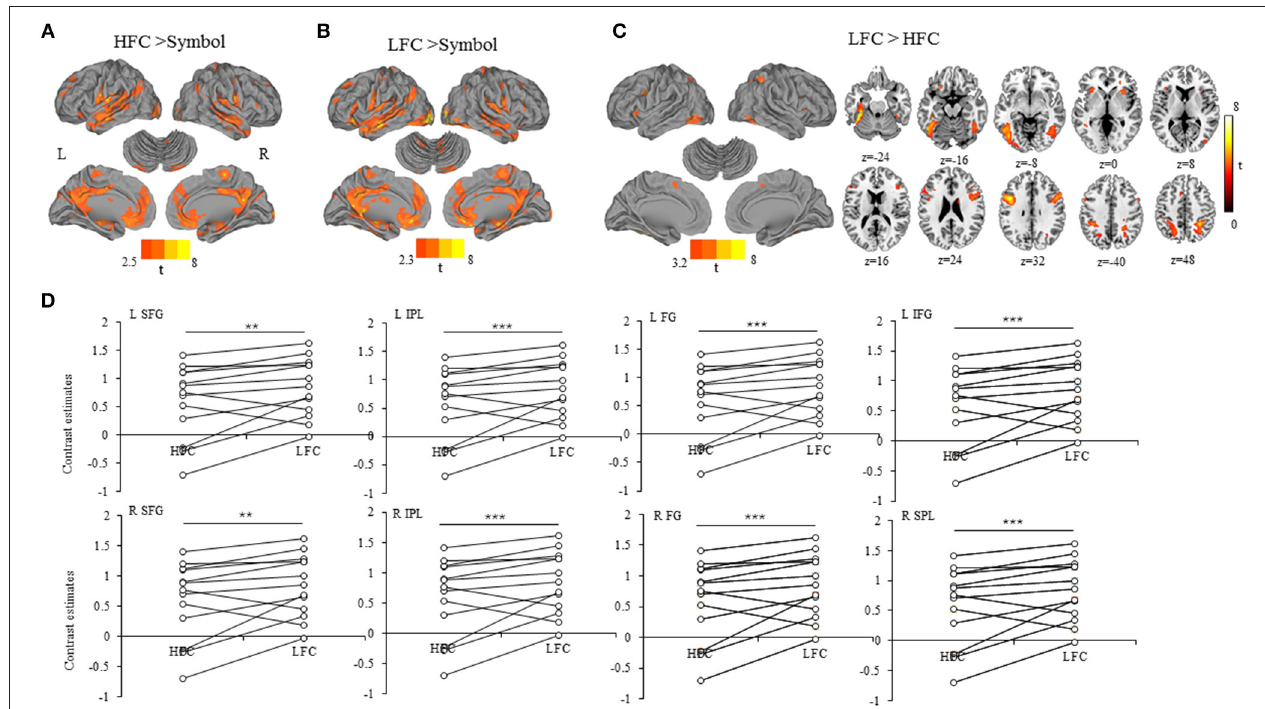
FIGURE 2 | (A) Activation for the contrast writing HFC minus drawing symbols. (B) Activation for the contrast writing LFC minus drawing symbols. (C) Activation for the contrast writing HFC minus writing LFC. The activation clusters were visualized using the Caret software version 5.5 (https://www.nitrc.org/projects/caret/). (D) Scatter plots of contrast estimates of the brain regions in relation to the word-frequency effect (LFC > HFC). Each closed circle represents one participant, and the dark lines link the identical participants. HFC, high-frequency characters; LFC, low-frequency characters; SFG, superior frontal gyrus; IPL, inferior parietal lobule; FG, fusiform gyrus; IFG, inferior frontal gyrus; SPL, superior parietal lobule; L, left; R, right. ** p < 0.01, *** p <